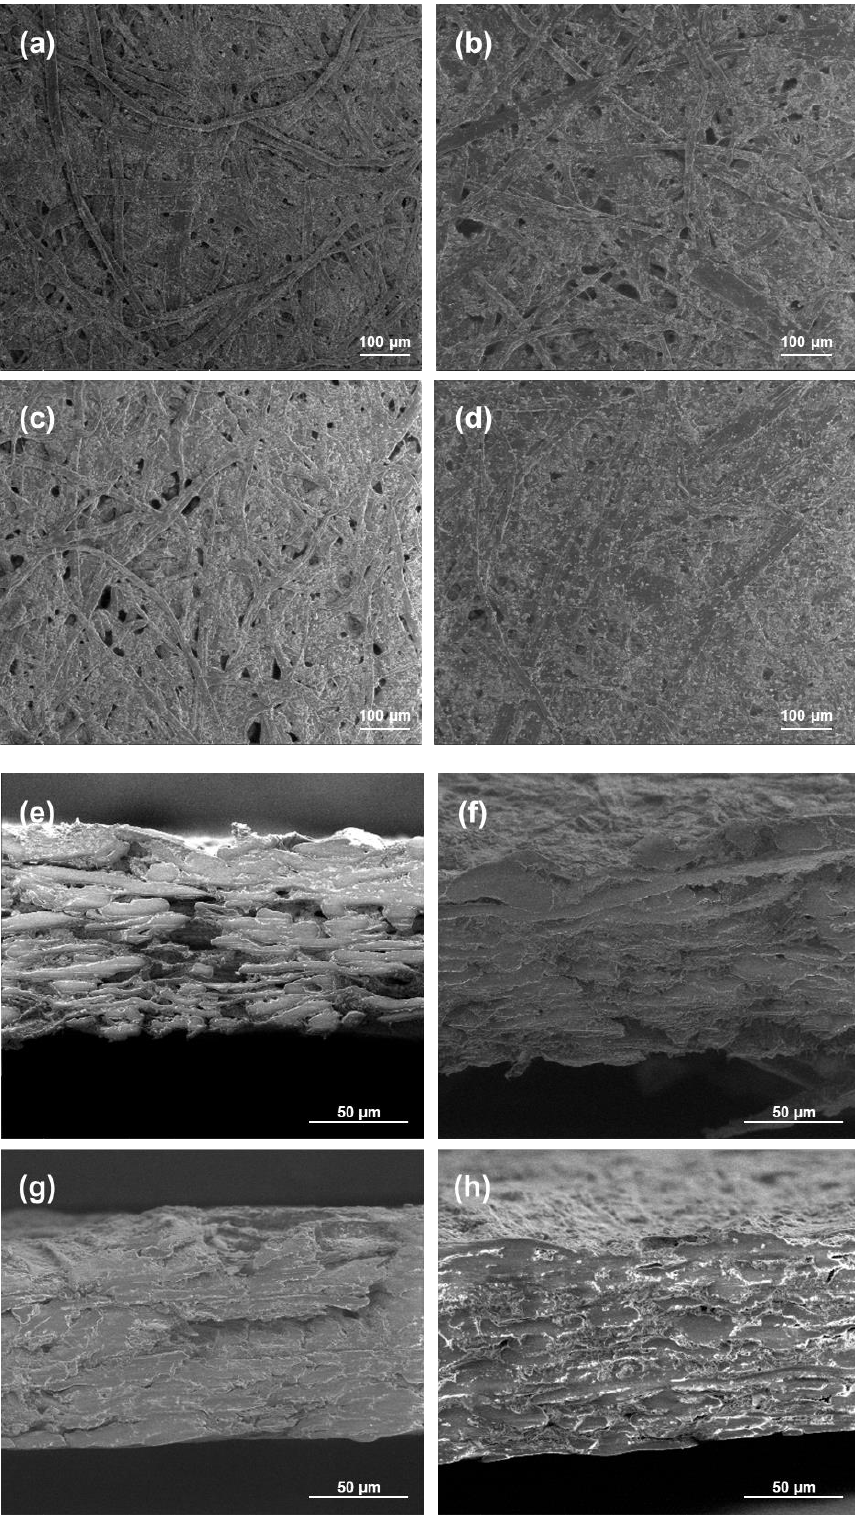
Figure 7. SEM micrographs of surface and cross-section of paper samples. For cross-section images, coated sides were on the top. ( a , e ) Uncoated paper; ( b , f ) 20 wt.% of modified PCC; ( c , g ) chitosan coating; ( d , h ) 50 wt.% of modified PCC.